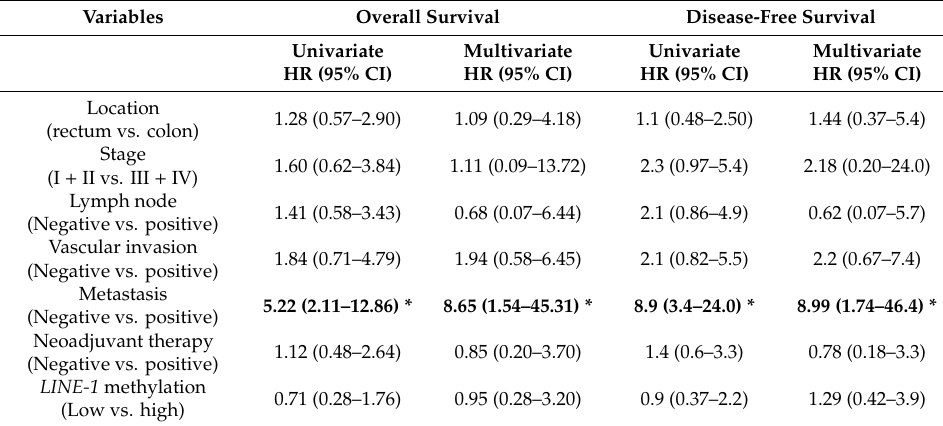
Table 2. Univariate and multivariate analysis for colorectal cancer patient survival.